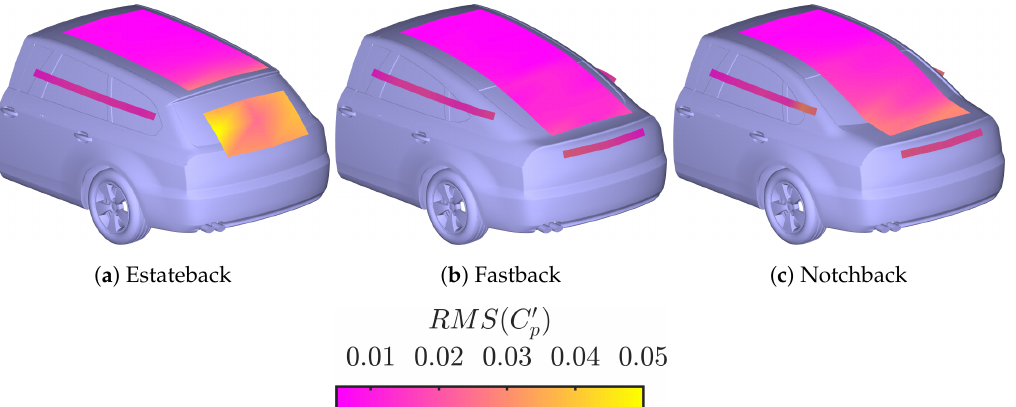
Figure 11. Mean of the surface pressures taken during the Y = − 0.190 m acquisition.